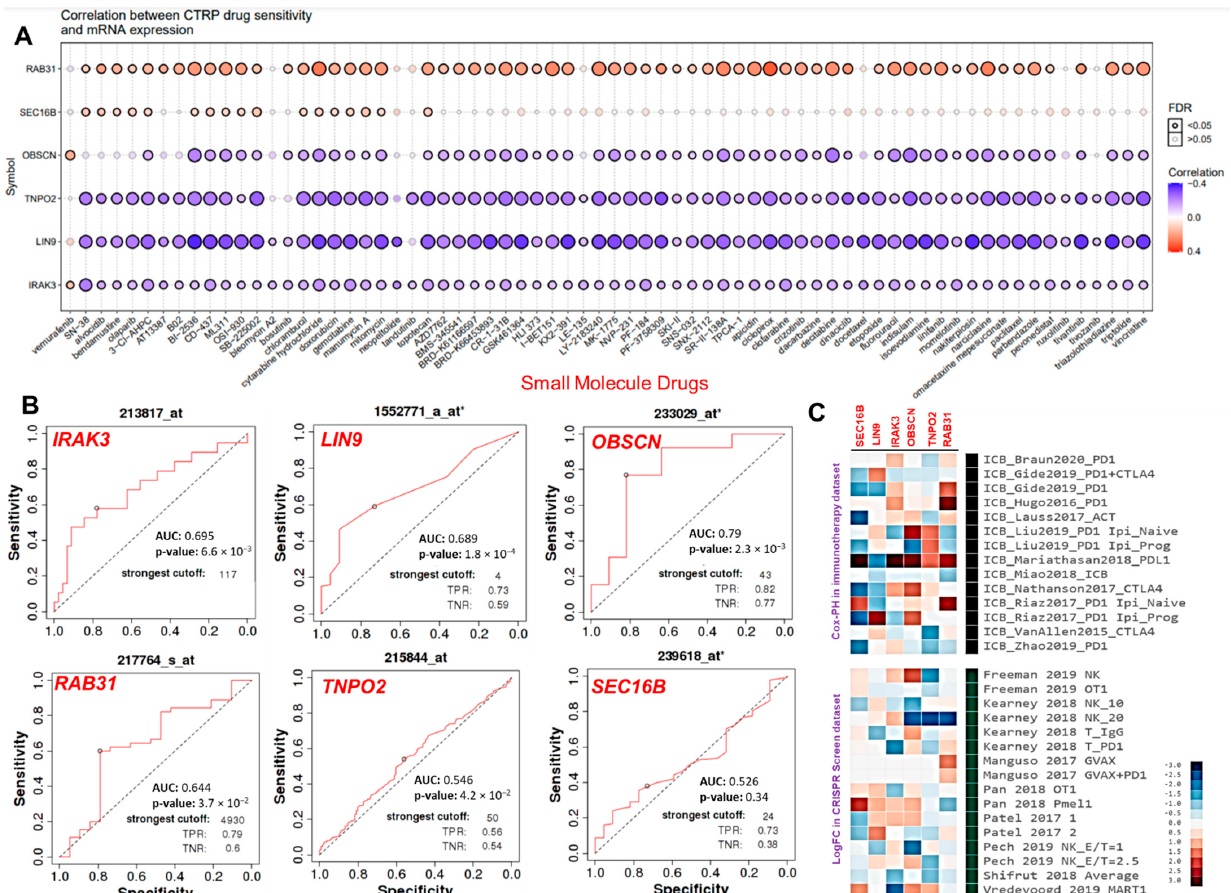
Figure 7. The cancer hub genes are associated with poor response to chemotherapy and immune checkpoint blockage therapy outcome. ( A ) Bubble plot of the correlation between mRNA expression levels of the hub genes and CTRP drug sensitivity. The color from blue to red represents the correlation between mRNA expression and the IC50 value of the small molecule drugs. The positive correlation means that the gene’s high expression is resistant to the drug, and vice versa. The bubble size positively correlates with the FDR significance. The black outline border indicates FDR < 0.05. ( B ) The ROC plotter of the association between the gene expression and sensitivity to chemotherapy in the hub cancer. ( C ) Heat map depicting the association between the hub genes with lymphocyte-mediated tumor killing in CRISPR screens and outcome in ICB sub cohort.